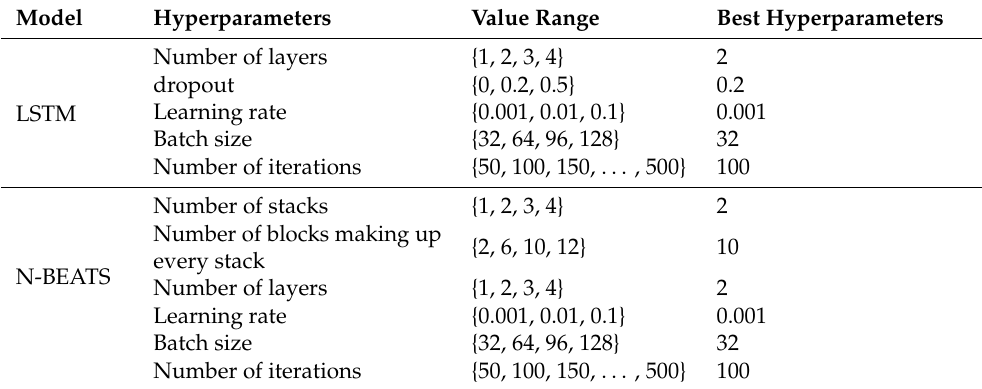
Table 3. Search range and optimized hyperparameters for the neural network models (LSTM, N-BEATS).